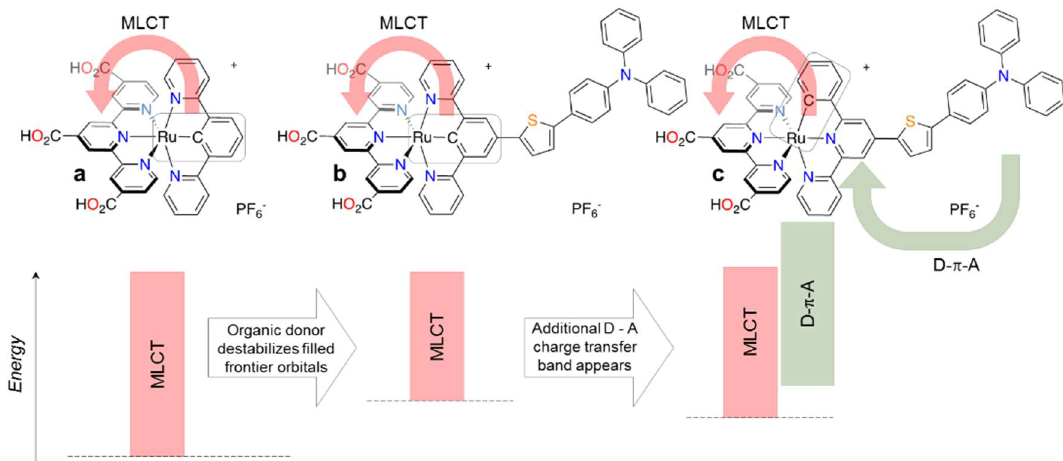
Figure 14. Design of bichromic sensitizers: moving from molecule a to b introduction of organic donor at the 1,3-bis(pyridine-2-yl)benzene (dpbH) cyclometalating ligand leads to destabilized filled frontier orbitals, and bathochromic shift of absorption spectrum. In case of molecule c with 6-phenyl-2,2′-bipyridine (pbpyH) cyclometalating ligand, additional D-A charge transfer band is appearing resulting in bichromic sensitizer.